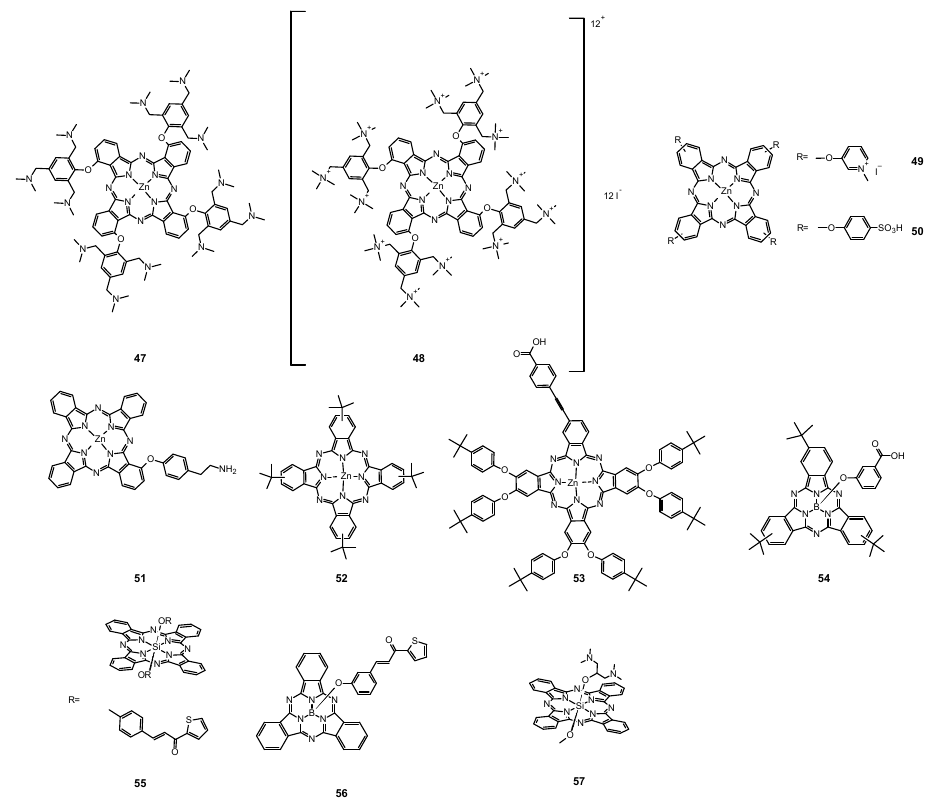
Figure 11. Chemical structures of ( 47 – 57